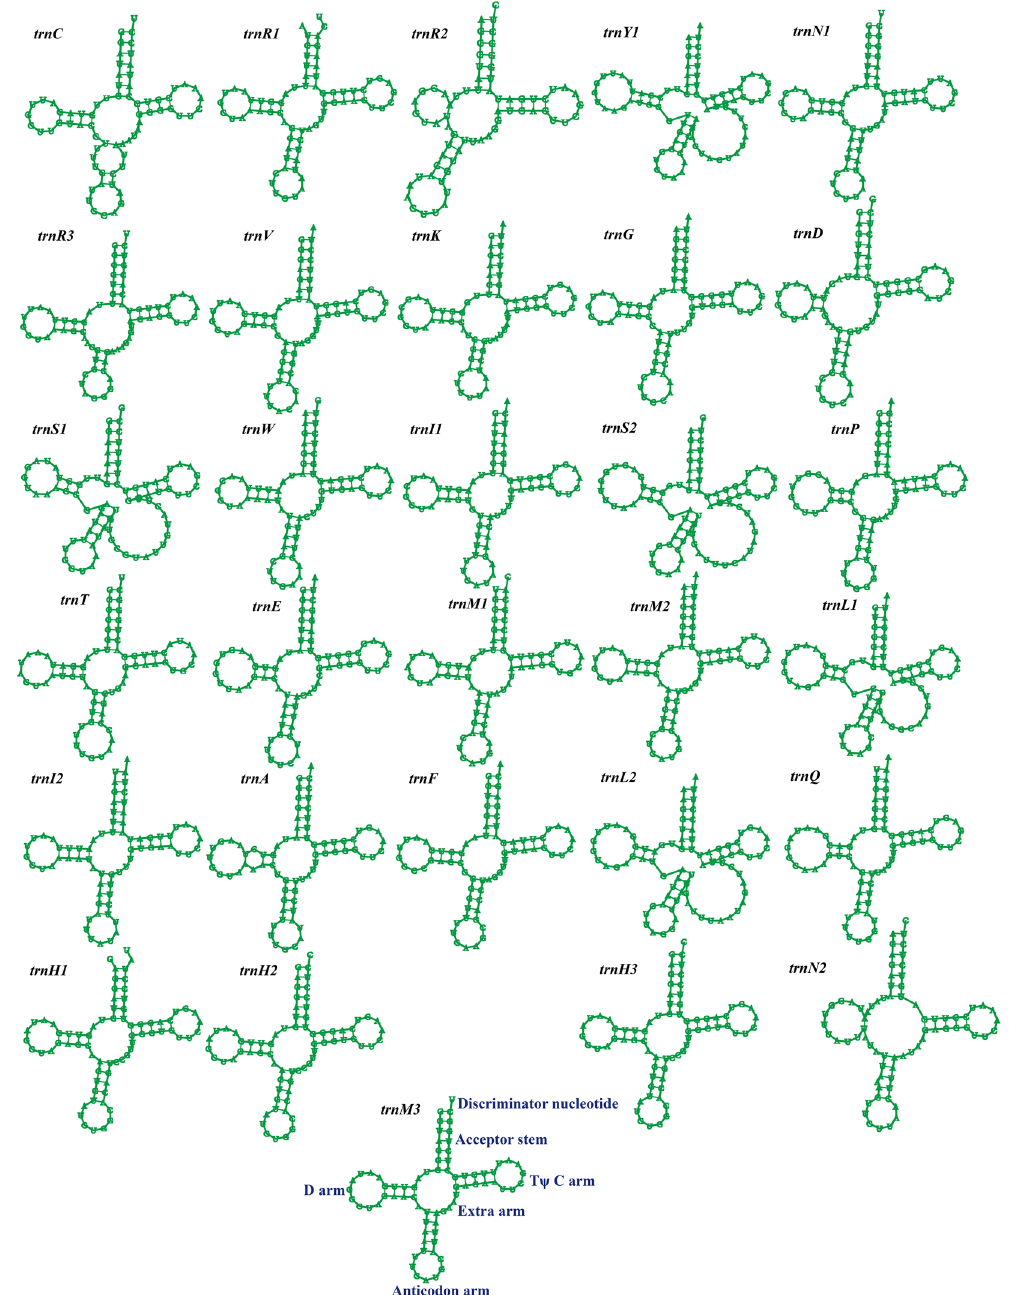
Figure 3. Putative secondary structures of the 30 tRNA genes from Scytalidium auriculariicola mitochondrial genome. The tRNAs are labeled with the abbreviations of their corresponding amino acids. The tRNA arms are illustrated as for trnM3. The map of tRNA structures was drawn using the mitos software 69